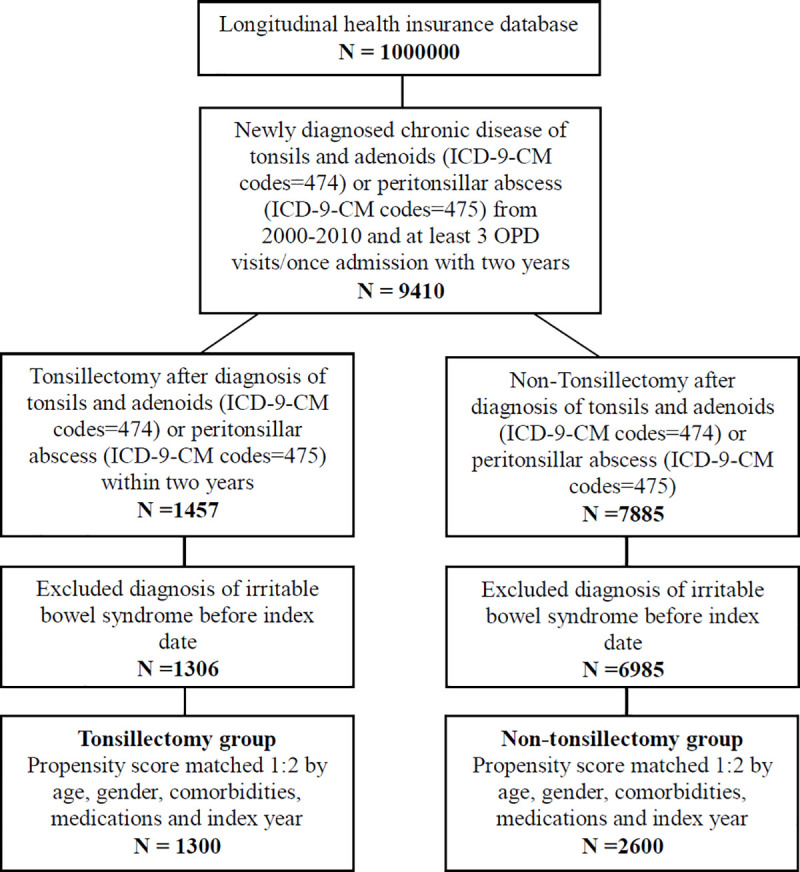
Flowchart of study.